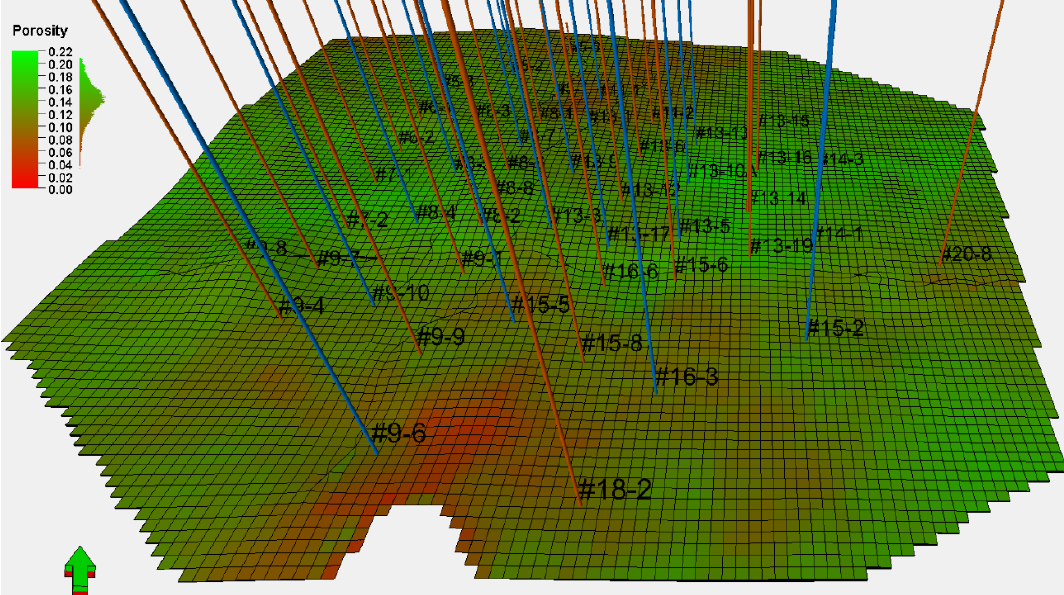
Figure 3. The dynamic model domain showing the porosity distribution for the top of the model with the injection wells in blue and production wells in red.